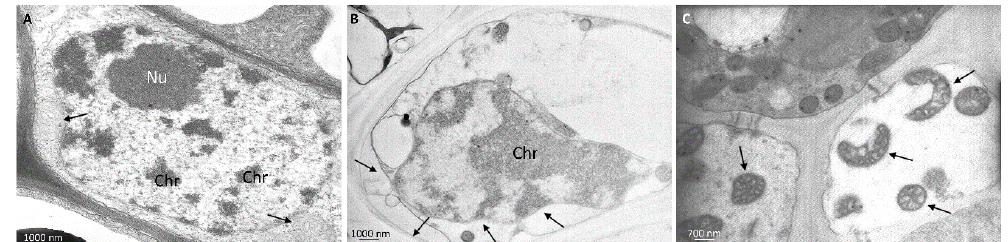
Figure 3. Representative TEM micrographs of leaf tissues from barley plants. In control untreated leaf tissues ( A ) nanoparticles are absent and chloroplast ultrastructure is well preserved. In plants grown